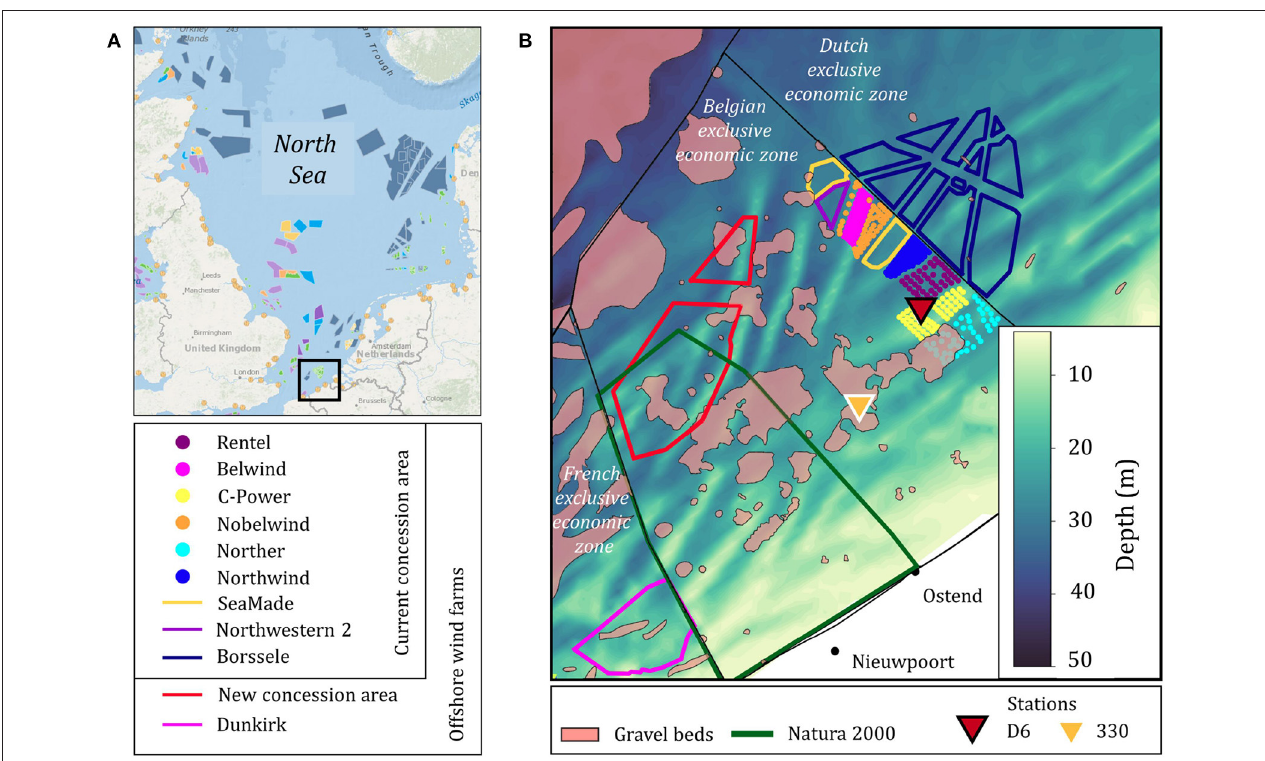
FIGURE 1 | (A) Overview of North Sea OWFs from a website https://www.4coffshore.com/offshorewind/, accessed on 31/10/2020. Black rectangular corresponds to the right panel (BCZ). (B) The BCZ (black contour) and distribution of OWFs (see the legend on the lower-left corner; and for further details— Table 2 ) which were operational by April 2020 (colored dots) or were under construction or planned (colored contours). The thick green line represents the Natura 2000 protected area; the gravel beds that host hotspots of biodiversity are colored in red-brown.